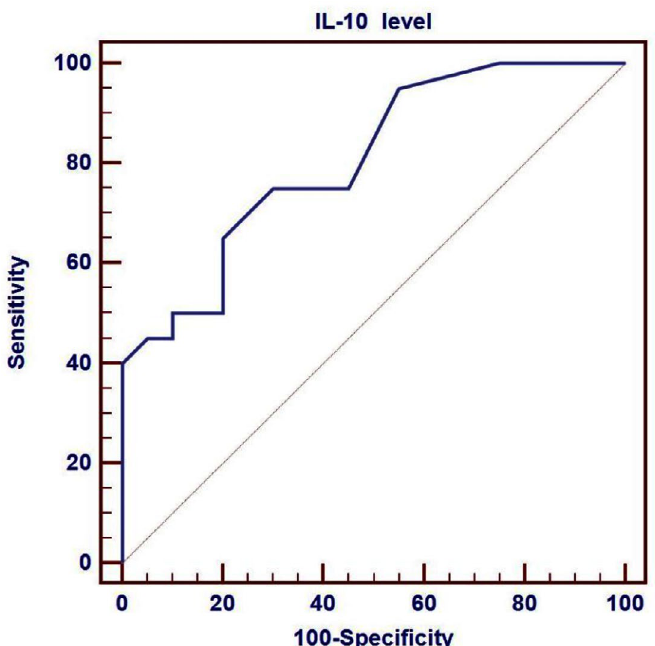
Fig. 2. ROC curve of plasma IL-10 levels to identify the severe COVID-19 patients from moderate patients. Performance of ROC curve of IL-10 for predicting severe COVID-19 patients. Receiver operating characteristic curve (ROC) was used to assess the best cut off point with its sensitivity, specificity, positive predictive value, negative predictive value and area under the curve (AUC) of IL-10.